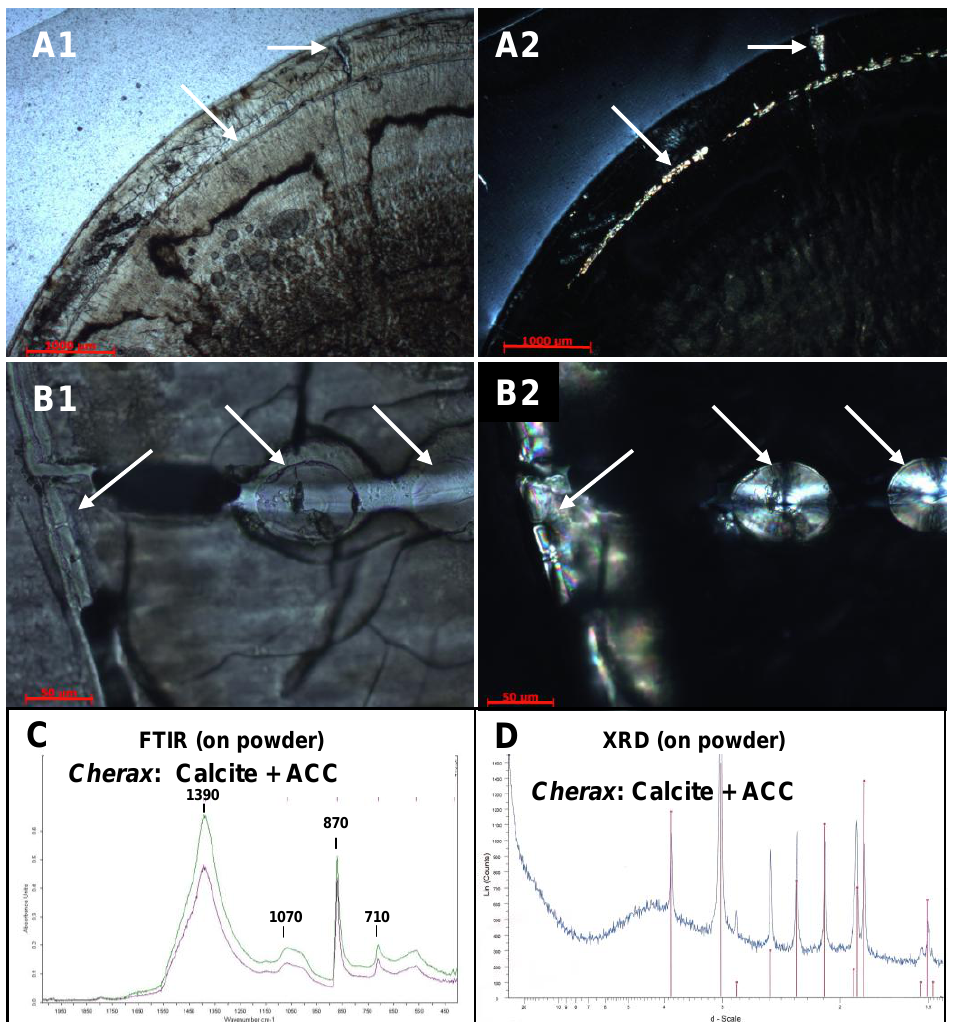
Figure 6. Observation of cross-sections of Cherax quadricarinatus gastrolith by A1, B1 : Non-Polarized Light (NPL) microscopy and A2, B2 : Polarized Light microscopy (PLM). Most of the gastrolith appears completely dark in PLM suggesting a non-crystallized structure. In a few samples, some areas exhibit a birefringent aspect (arrows) corresponding to the presence of crystallized mineral. In these particular cases, FTIR ( C ) and XRD ( D ) spectra show a mix of two CaCO polymorphs: ACC and calcite. 3 A2